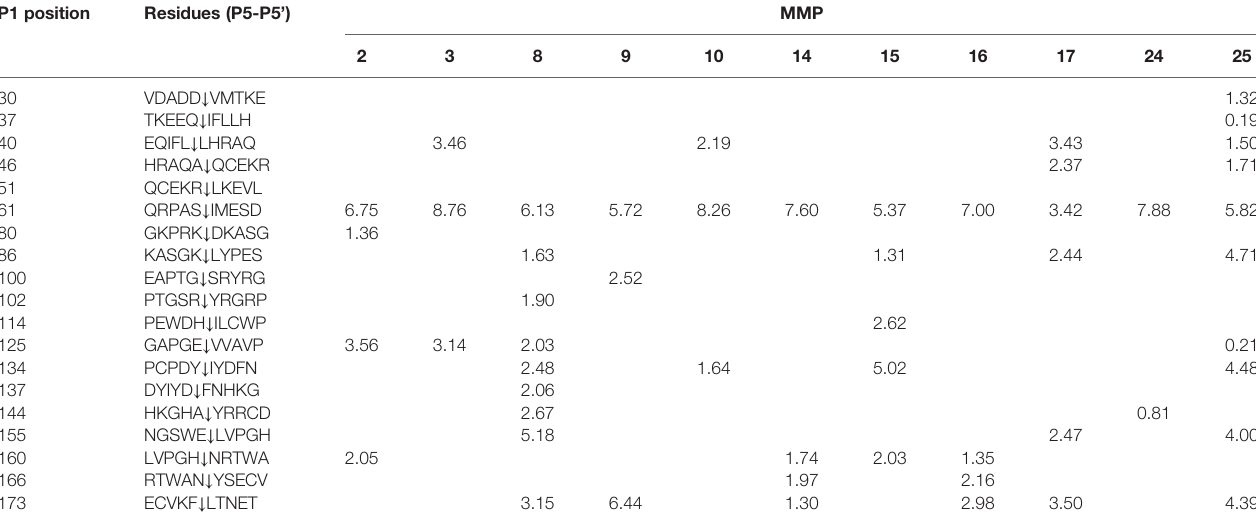
TABLE 1 | Computational cleavage site prediction of PTH1R